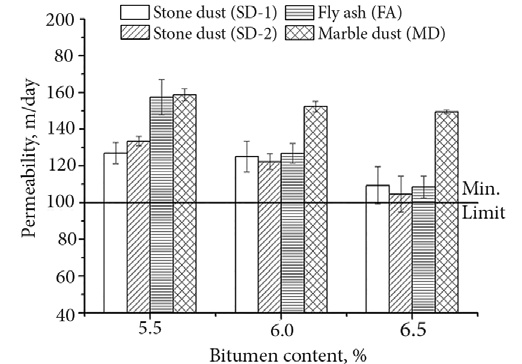
Fig. 11. Permeability of OGFC mixes